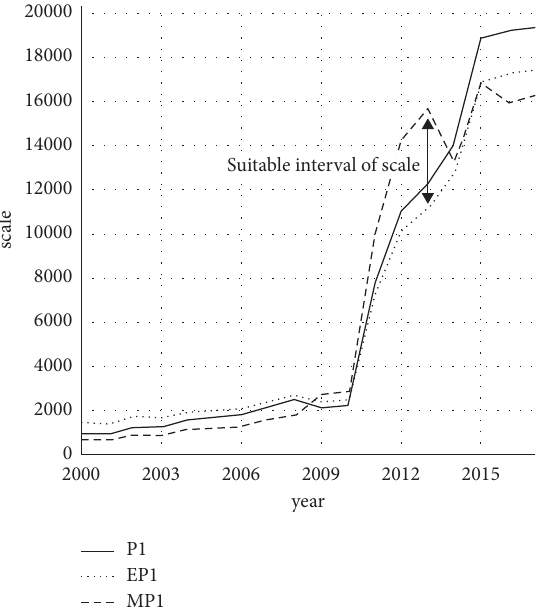
Figure 2: Trend comparison of P